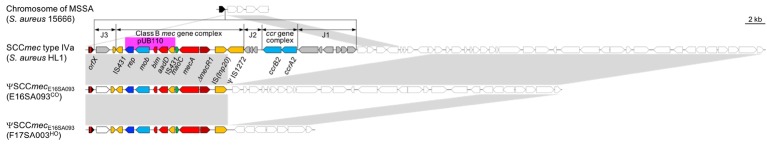
Genomic structures and environments of the ΨSCCmec
E16SA093 element in comparison with the SCCmec type IVa in MRSA HL1 (Chen et al., 2013) (GenBank accession, CP003979) and orfX in MSSA 15666 (GenBank accession, EU272085). The conserved region in the gray box showed a resemblance of >99% nt identity. Filled arrows represented the components consisting of the SCCmec element. The open arrows indicated the presence of chromosomal genes in S. aureus. Arrows in black, orfX; red, resistance genes; yellow, transposase; blue, replication origin; sky blue, recombinase; gray, hypothetical coding sequence.